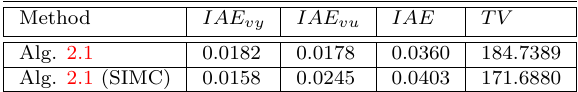
Table 10: Example 3.7. Shows the indices IAE vy , IAE vu , IAE (sum) and TV for Alg. 2.1 where δ = 1 . 6, and Alg. 2.1 (SIMC) where T c = 1 . 5 τ .